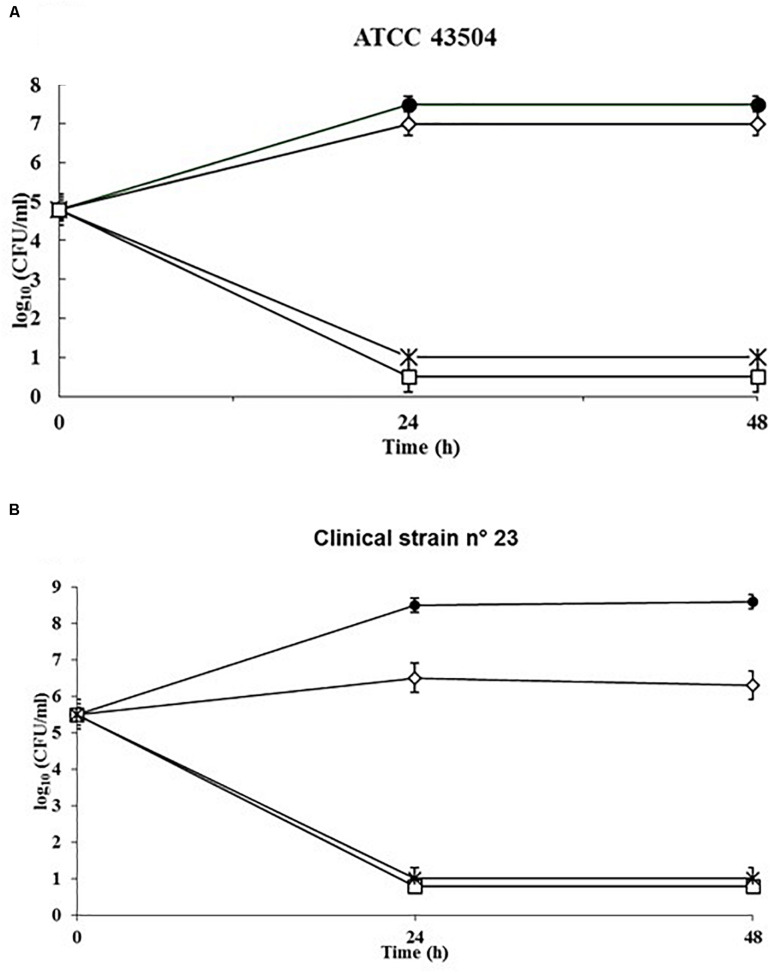
Kinetics of the killing activity of SUNCs against H. pylori ATCC 43504 and the clinical isolate H. pylori 23 by SUNCs. Antibacterial activity was evaluated in RPMI Megacell with 3% FCS in the presence or absence of the SUNCs concentrations for different time points. The MIC value of H. pylori ATCC 43504 (A) and clinical H. pylori 23 (B) was 0.33 mg/L. The data are expressed as mean CFU ± SD recovered from three different experiments performed in duplicate. Symbols: filled circle, control; open diamond, 0.5× MIC; asterisk, 1× MIC; open square, 2× MIC.